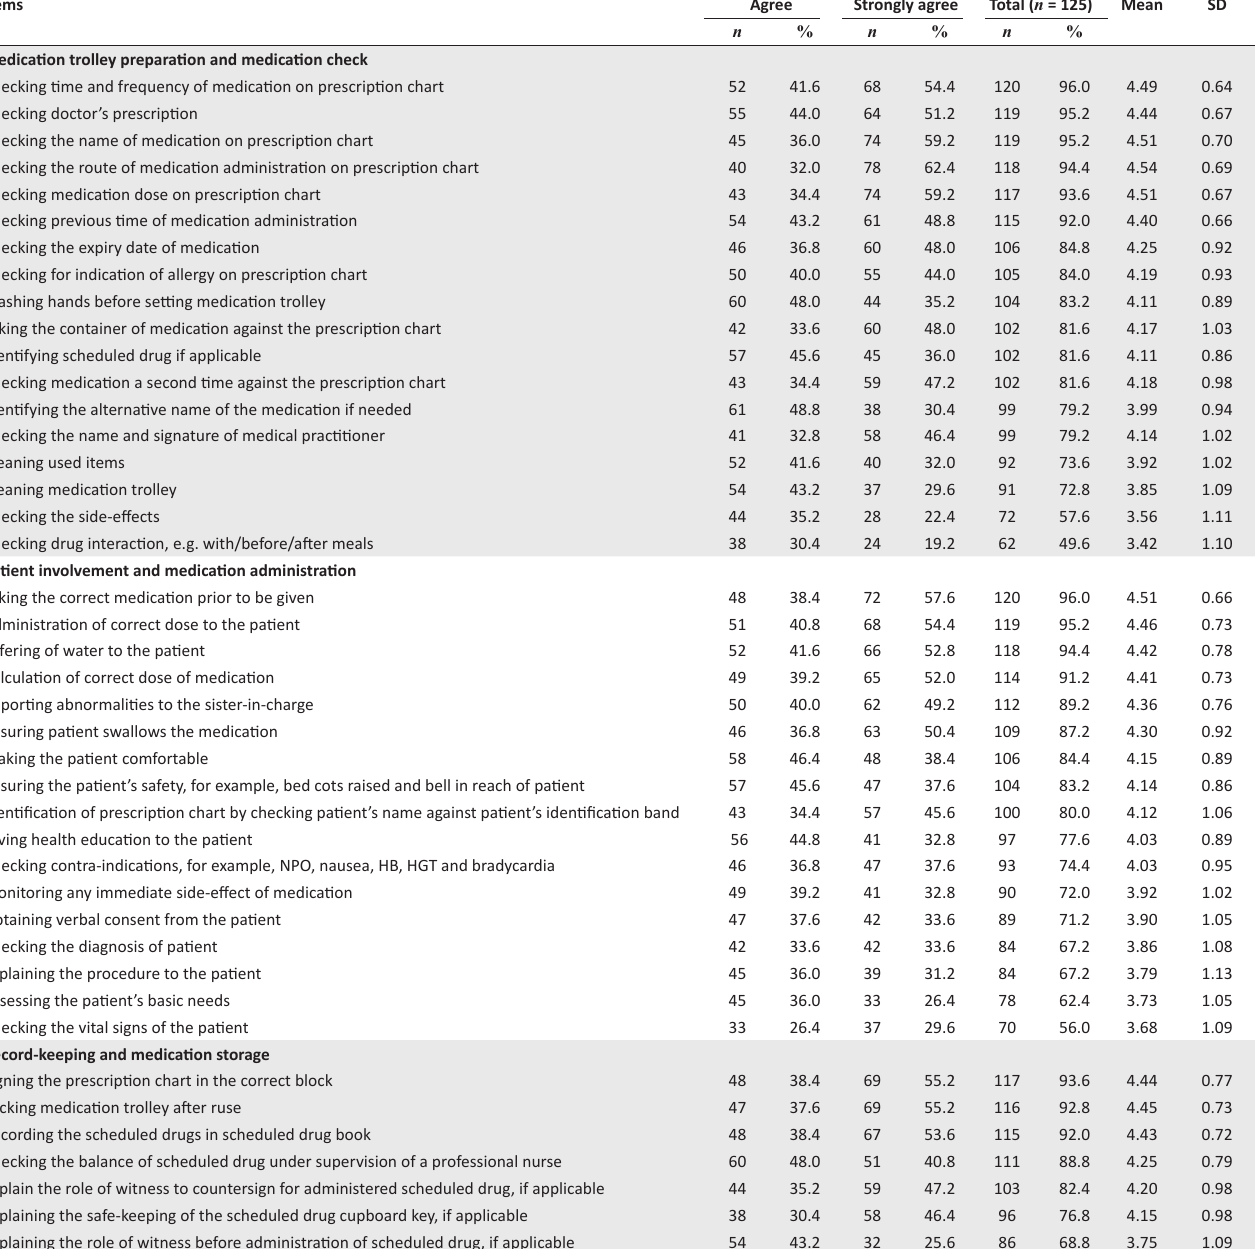
TABLE 2: Perceived competence in medication